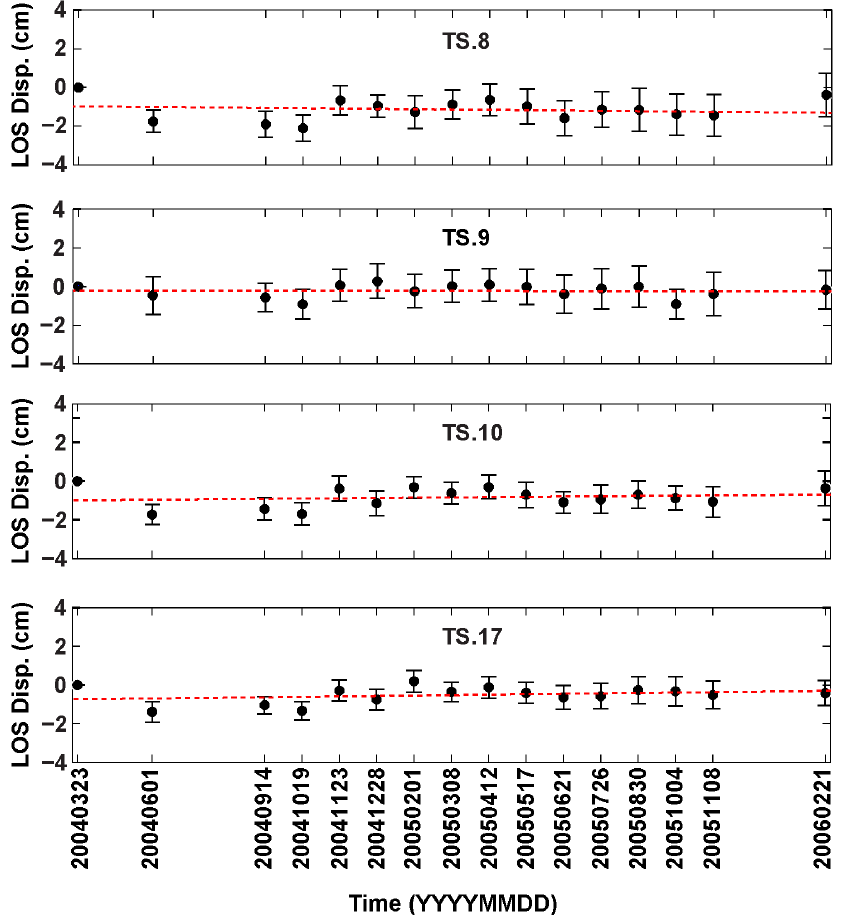
Figure 10. Four samples of InSAR time-series diagrams at TS8, TS9, TS10 and TS17; for the location of the points, please see Figure 9b. The solid circles on the diagrams represent the displacement values and the dashed red line is a one-dimensional polynomial trend fitted to displacement values. The displacement values and error bars have been computed for a window size of 100 m centered on each pixel.